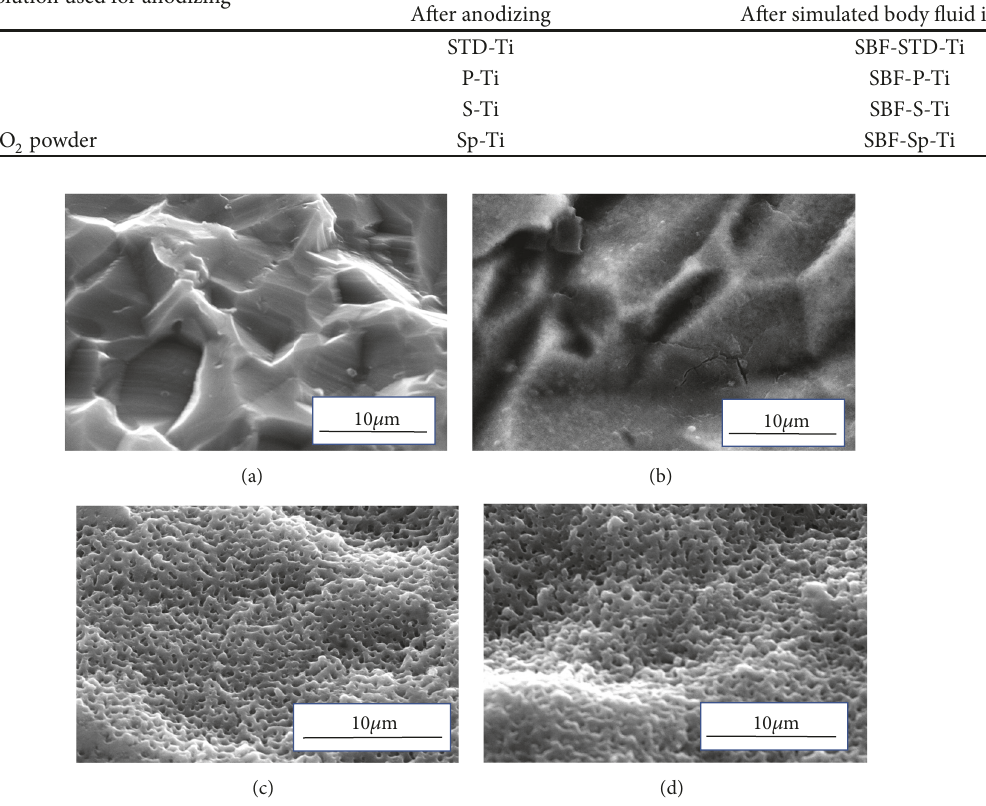
Figure 1: SEM photos of the surface of the Ti plate samples. (a) STD-Ti, (b) P-Ti, (c) S-Ti, and (d) Sp-Ti.